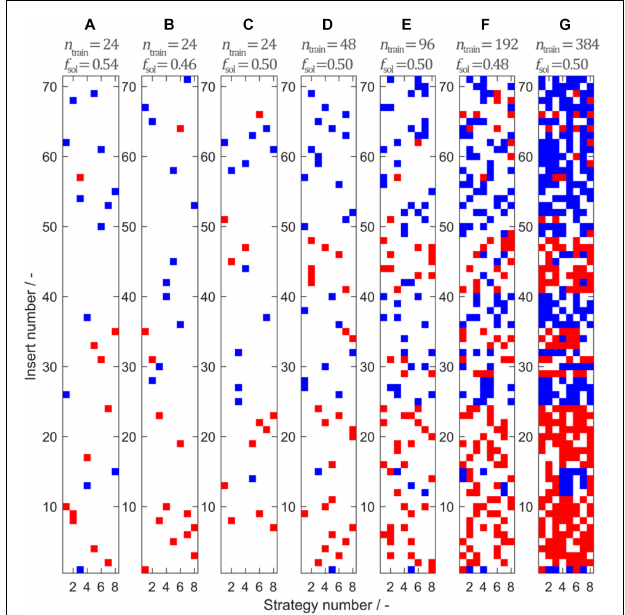
FIGURE 3 | Model training sets 1–7 (A – G ) created by stratified sampling of n train = { 24 , 24 , 24 , 48 , 96 , 192 , 384 } data points. Stratified sampling was informed by the construction of the entire data set, where eight insertion strategies were used for 71 different inserts, amounting to a total of 568 observations. While for the sampling procedure the solubility data of the observations were unknown, their solubility class is illustrated for interpretation purposes. Blue represents soluble and red represents insoluble observations. The fraction of soluble observations is indicated above the plots by f sol